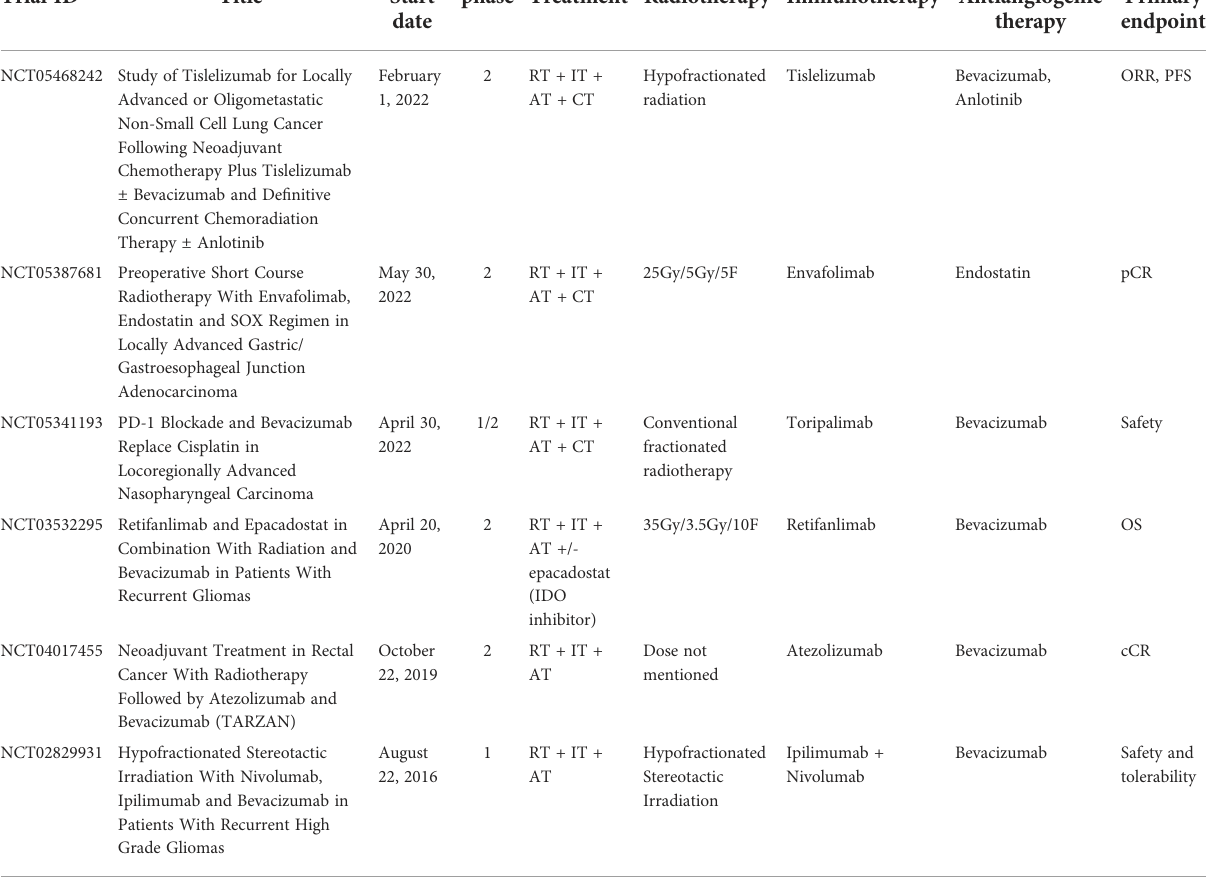
TABLE 1 Clinical trials of combining antiangiogenic therapy with radiotherapy and